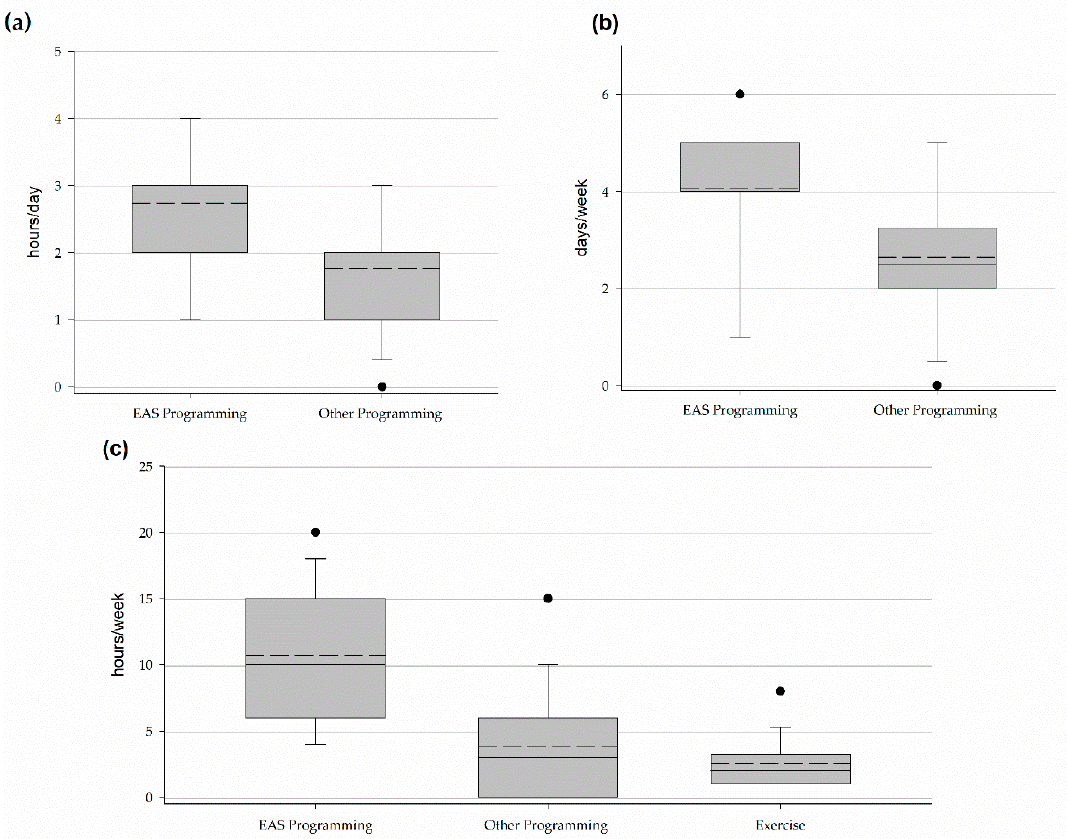
Figure 3. Workload of horses in Florida PATH Intl. centers. EAS programming includes adaptive or therapeutic riding, vaulting, driving, equine assisted therapy, and equine assisted learning. Other programming includes such things as summer camps and lessons for riders without disabilities. Exercise includes structured exercise and conditioning activities